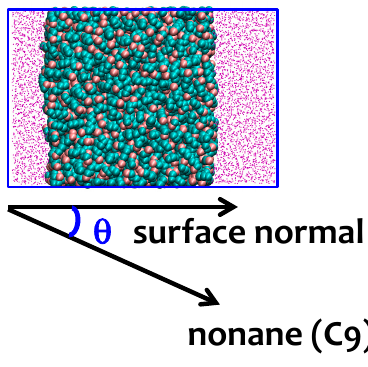
Figure 2. The orientation of the alkane molecules is characterized by the angle θ between the alkane molecules and surface normal. The upper panel shows a typical snapshot of the water–nonane simulation cell. Methyl groups are shown with pink beads and methylene groups with cyan beads. Water is represented by magenta points. Blue squares denote the periodic boundaries of the simulation box. The lower panel illustrates the relation between the angle θ and the orientation of nonane.